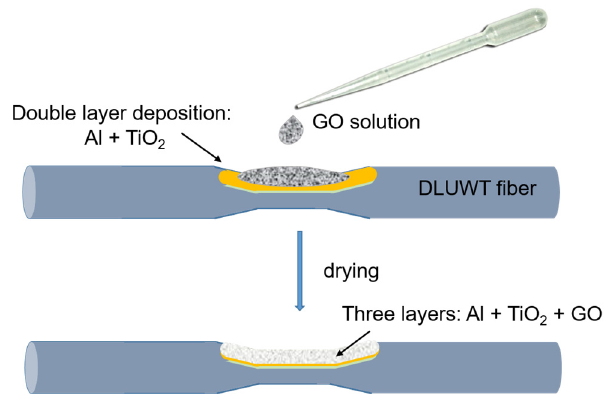
Figure 2. Schematic GO deposition method. A model of the DLUWT is shown. A drop of GO solution is deposited (above) and after drying a third layer is present in the device (below). Further details in the body text.